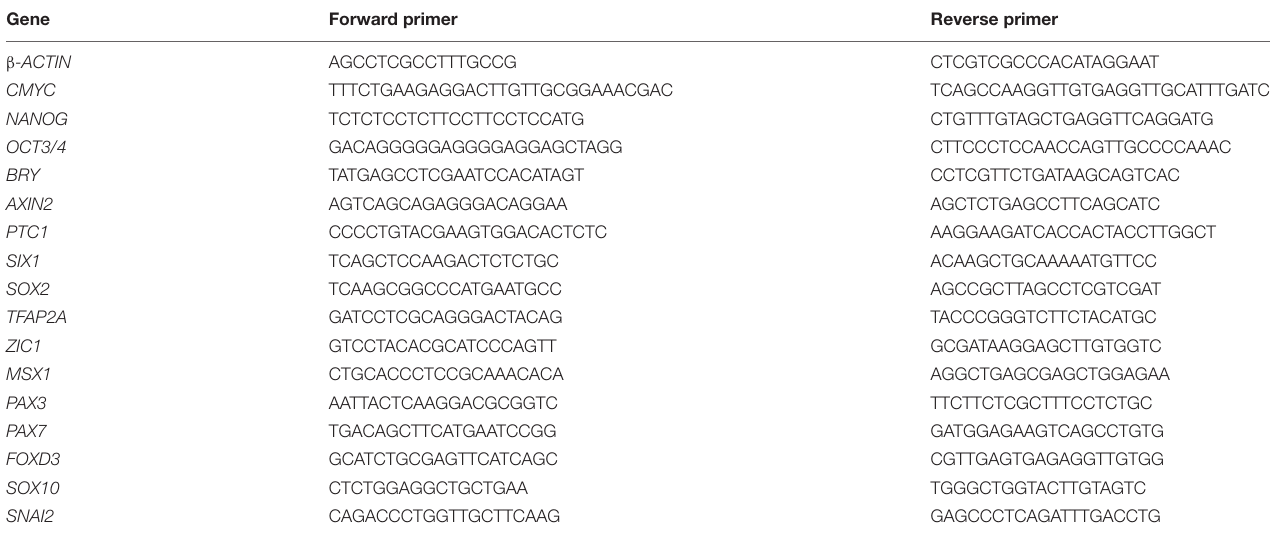
TABLE 3 | RT-qPCR primers used in this